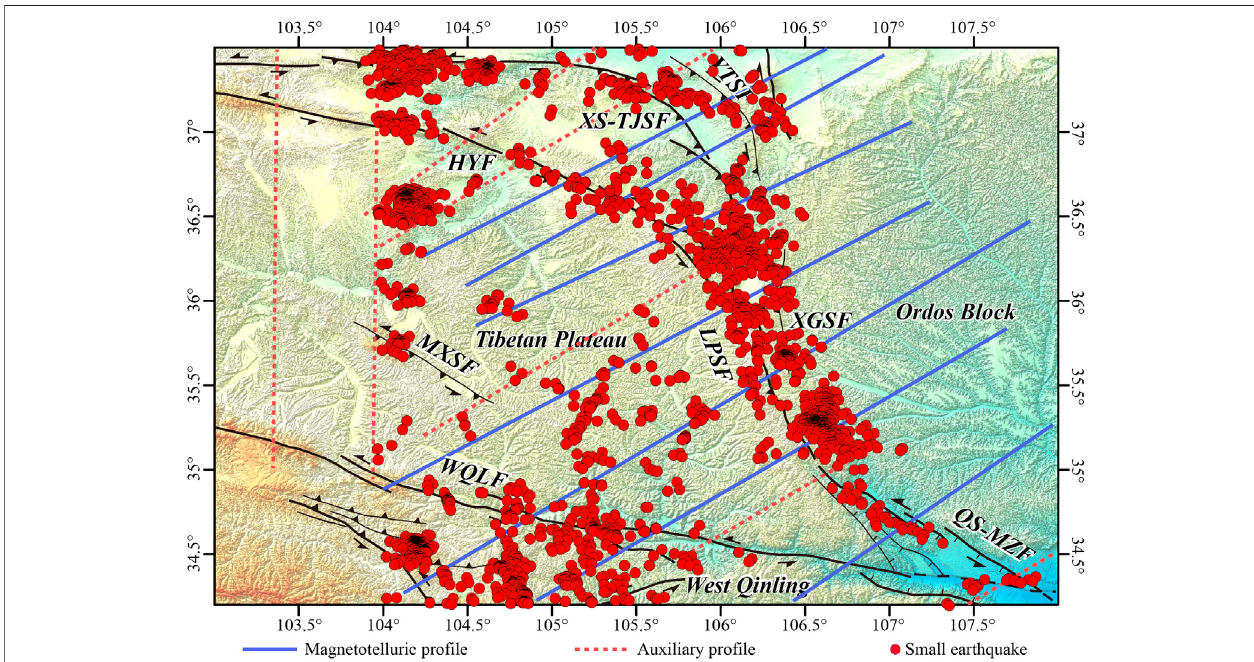
FIGURE 5 | Distribution of modeling pro fi les and small earthquakes in the V2 model. Small earthquakes occurred from 1 January 1990 to 30 June 2018, with magnitudes less than 6.7 (Zhan et al., 2020).